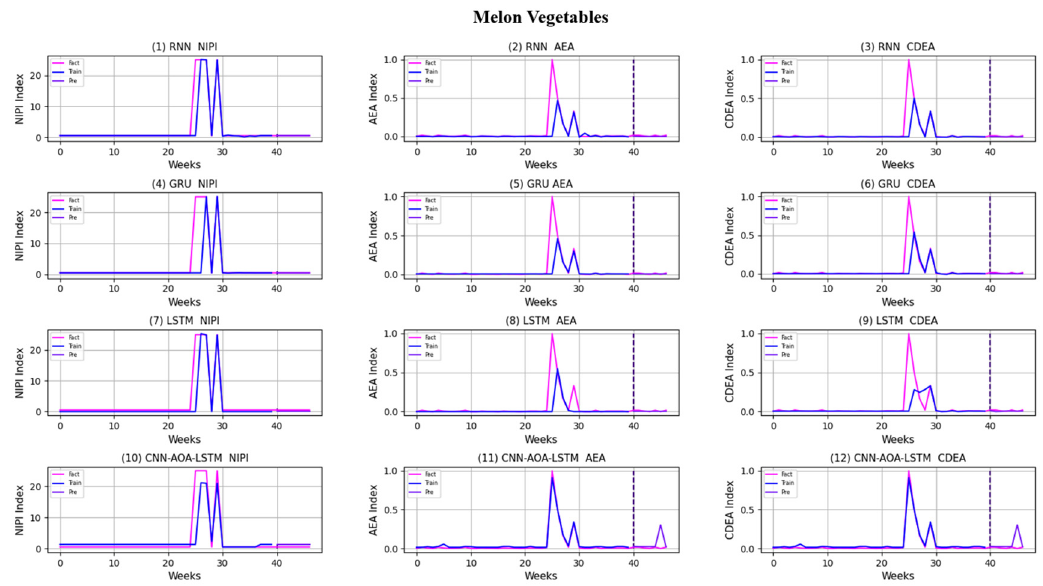
Figure 11. Prediction results of indexes of bulb vegetables.